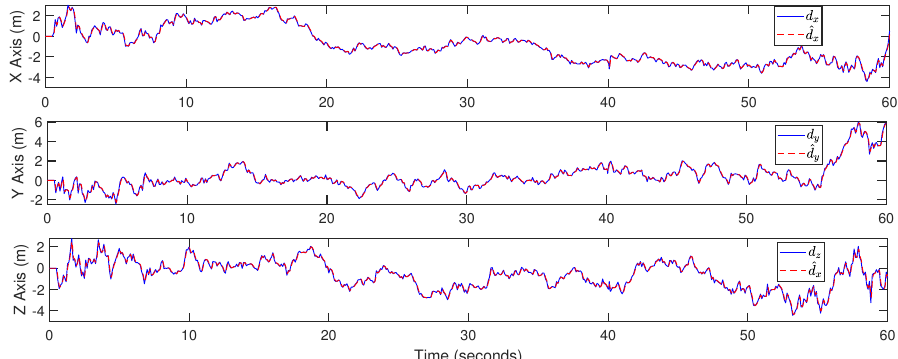
Figure 21. Disturbance observer outcome for position subsystem with Von Karman wind turbu- lence model.